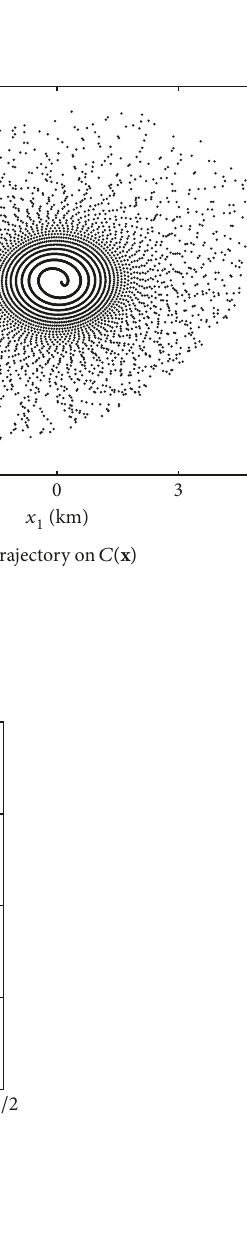
Figure 16. For all of the state cells with an initial radial position 𝑙 > 8 km and an initial radial velocity ̇𝑙 0 parameter domain corresponds to the blue zone in Figures 16(a) and 16(b). These figures show that the contrasted red zone decreases as 𝑙 0 decreases or